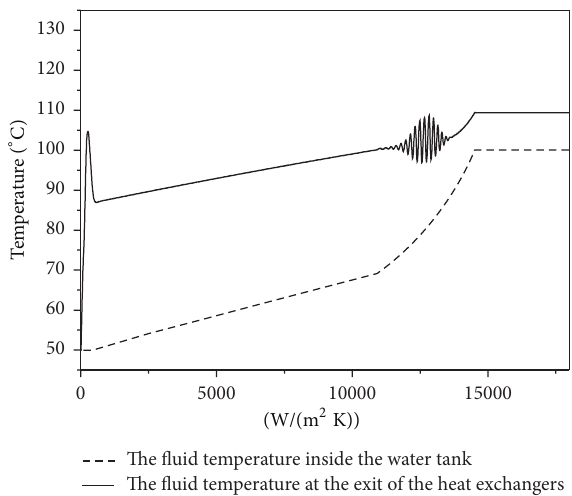
Figure 4: The temperature evolution at typical position after OLPCCS being activated.